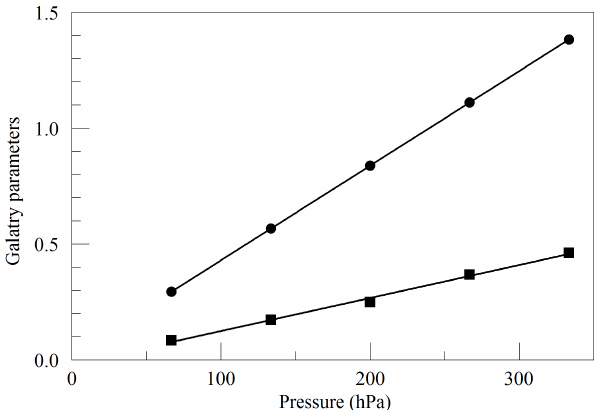
Figure 2. Best-fit values for the Galatry parameters of the Q13Q13 line of O 2 , as a function of pressure. The line broadening parame- ter y is represented by circles, and the line narrowing parameter z is represented by squares. The solid lines are linear fits to the mea- surements. The respective best-fit offset and slope are 0.0227 and 0.004082hPa − 1 for y , and − 0 . 0169 and 0.001424hPa − 1 for z .